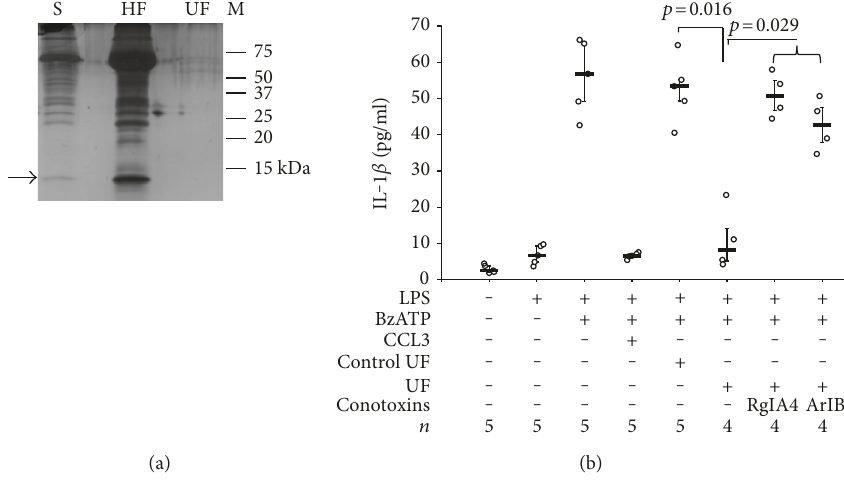
Figure 5: Release of small mediators in response to CCL3. U937 cells were primed with LPS (1 μ g/ml, 5h) and activated with 2 ′ (3 ′ )-O-(4- benzoylbenzoyl)adenosine-5 ′ -triphosphate (BzATP; 100 μ M, 30min). The release of IL-1 β to the cell culture supernatant was measured by ELISA. CCL3, which was included as a positive control, inhibited the BzATP-induced release of IL-1 β . An ultra fi ltrate (UF) was produced containing the low molecular mass fraction ( < 3kDa) of the cell culture supernatant (S) of LPS-primed U937 cells treated with CCL3 (10 ng/ml) for 30 min. For the production of control UF, CCL3 was added to the cell-free supernatant of LPS-primed U937 cells shortly before ultra fi ltration. (a) The UF and the high molecular mass fraction (HF) obtained by ultra fi ltration were separated in a 15% SDS- polyacrylamide gel along with a molecular mass marker (M) followed by silver staining. The arrow is pointing to the band corresponding to CCL3. Proteins with higher molecular mass are bovine serum albumin (66.5kDa) and its contaminations that were added to the CCL3 preparation for stabilization. One typical result out of 5 experiments is depicted. (b) Control UF had no e ff ect on the BzATP-induced release of IL-1 β by LPS-primed U937 cells, whereas UF signi fi cantly reduced the IL-1 β release. The e ff ect of the UF was sensitive to conotoxins ArIB [V11L,V16D] (200nM) and RgIA4 (200nM). Data are presented as individual data points, bars indicate median, and whiskers percentiles are 25 and 75.